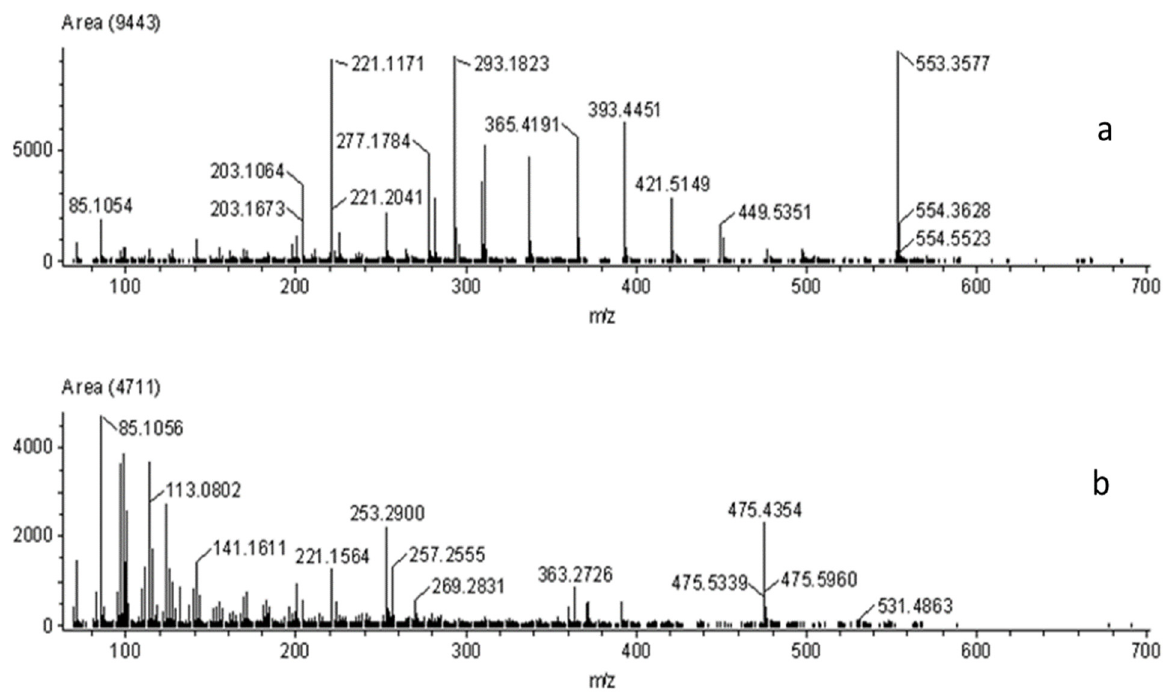
Figure 7. DART-AccuTOF ™ mass spectra for standards ( a ) polyethylene and ( b ) polypropylene at 30 V.